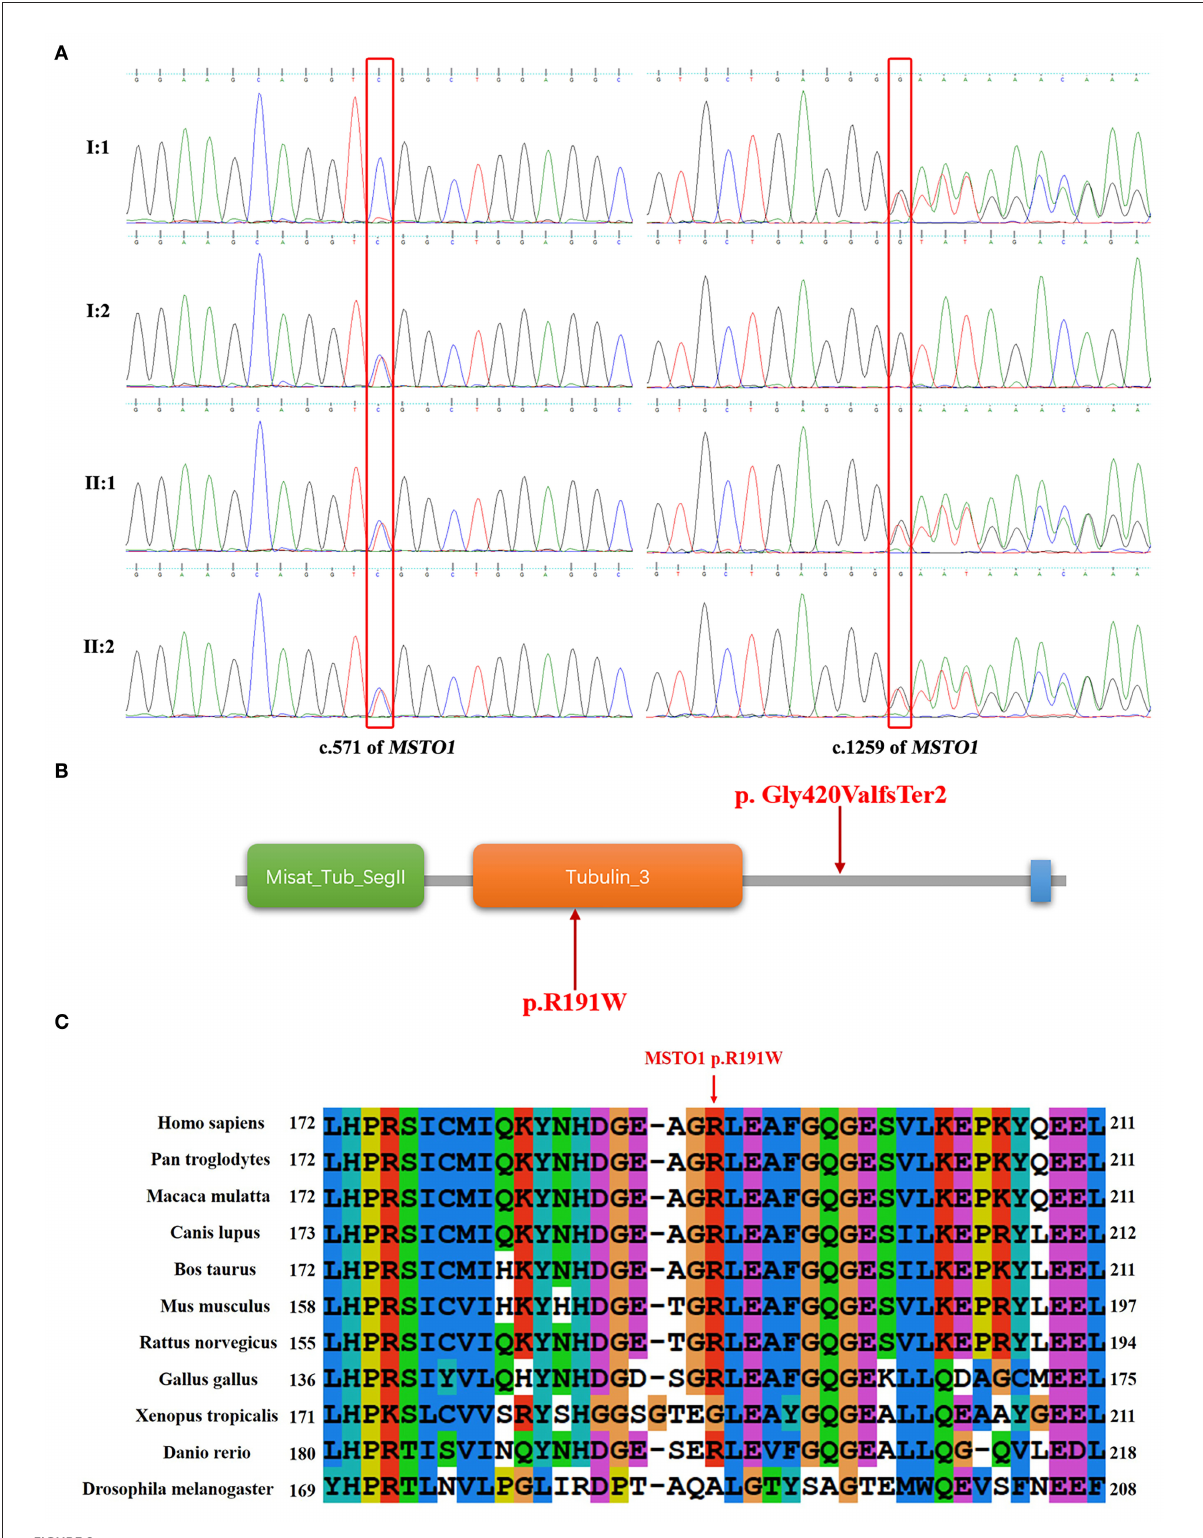
FIGURE2 Sequence results of the MSTO1 variants and analysis of the variants in domains of MSTO1. (A) Sequence chromatograms of the c.571C > T and c.1259delG variants of MSTO1 detected in the family members. (B) The domains of the identified MSTO1 variants located. The amino